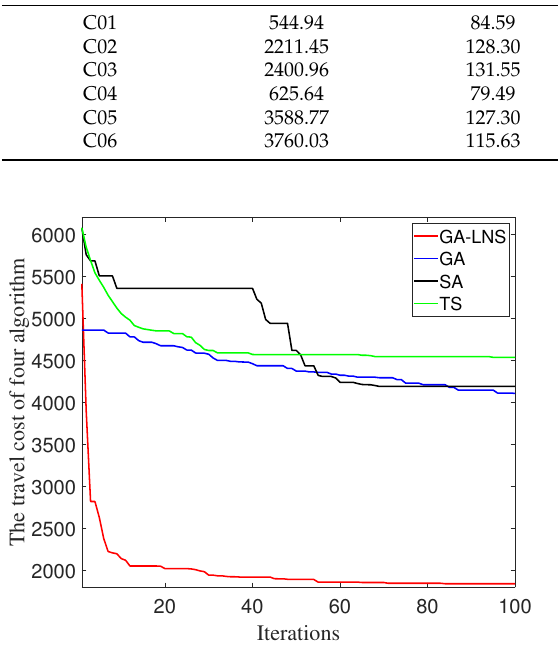
Figure 6. The iterative curve of four algorithms on